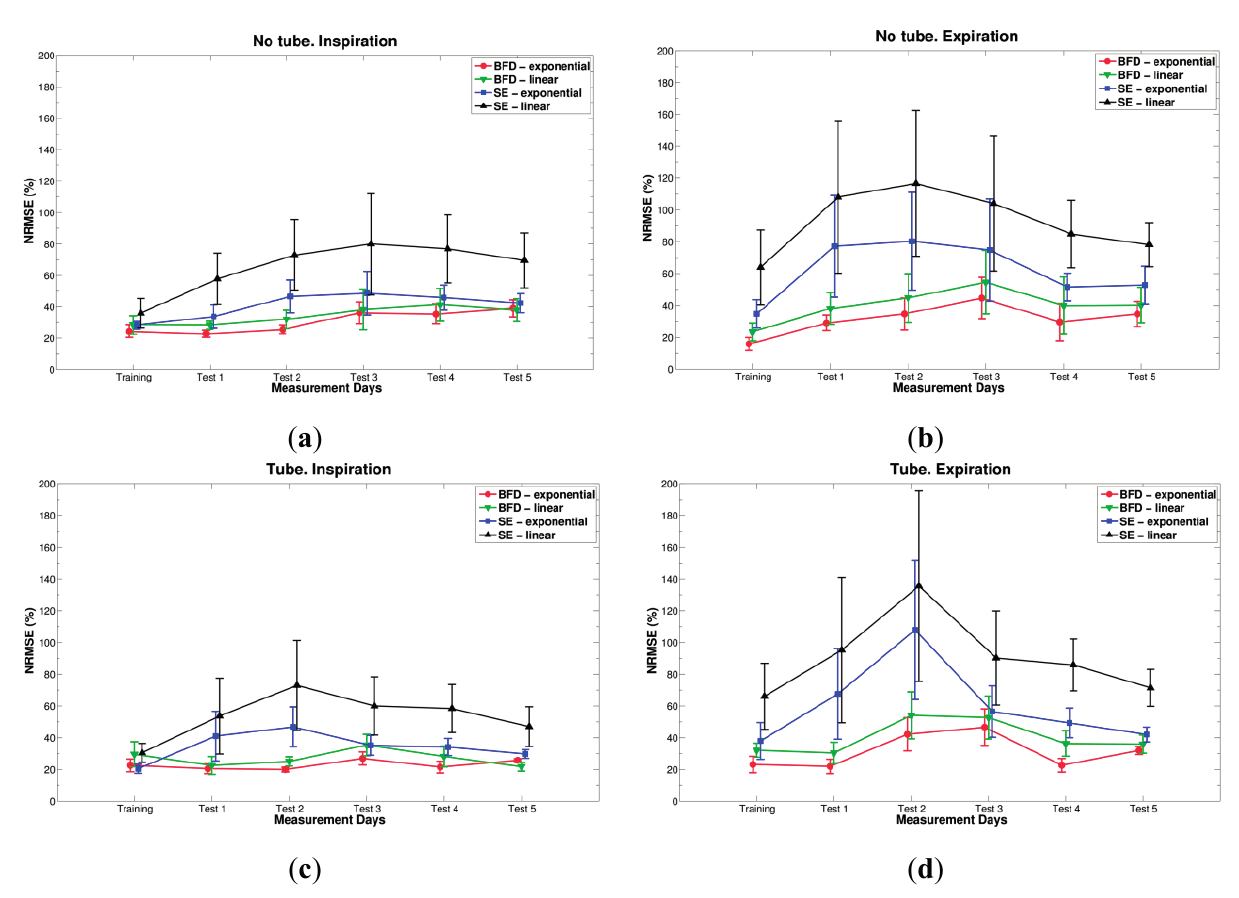
Figure 7. NRMSE errors (represented with its mean and standard error of the mean) when: BFD and exponential model (red circles), BFD and linear model (green downward triangles), SE and exponential model (blue squares), and SE and linear model (black triangles) are used. ( a ) No tube and inspiration; ( b ) No tube and expiration; ( c ) Tube and inspiration; ( d ) Tube and